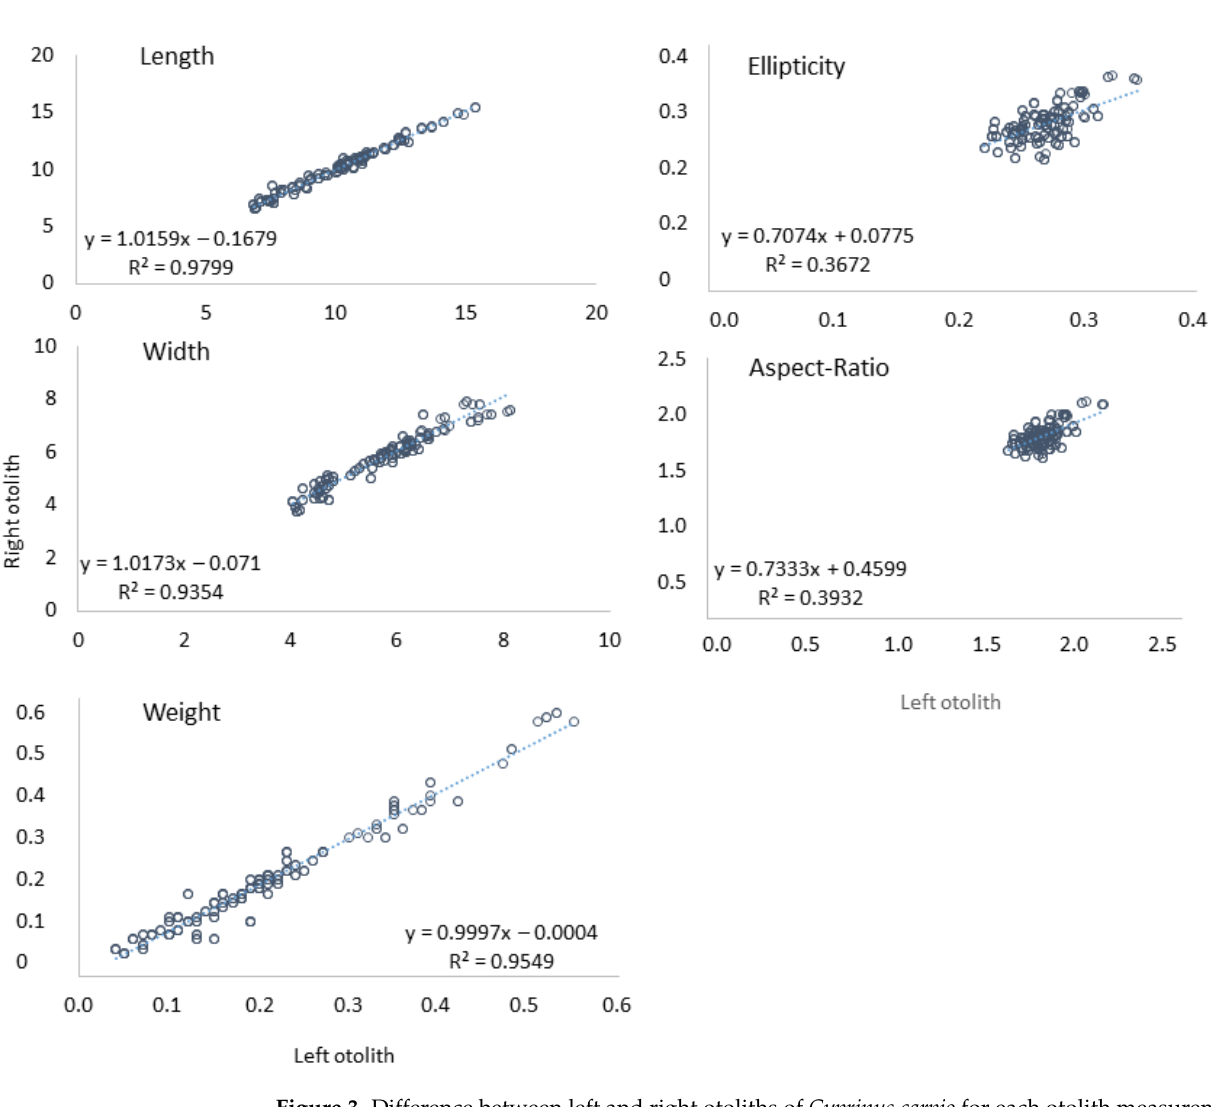
Figure 3. Difference between left and right otoliths of Cyprinus carpio for each otolith measurement. Table 1. p -values of generalized linear models for the relationship between fish length and each otolith variable for Cyprinus carpio collected from three localities in Iraqi rivers with by geographical and Side effects (observed from the interaction between Otolith feature and river or side in the GLM: Otolith feature: River/Side). The environmental effects on the relationship between fish length and each otolith variable (Otolith feature: T °C/Side and Otolith feature: pH/Side) were tested with three different values (mean, minimal and maximum). Grey cases show significant effects ( p < 0.05).